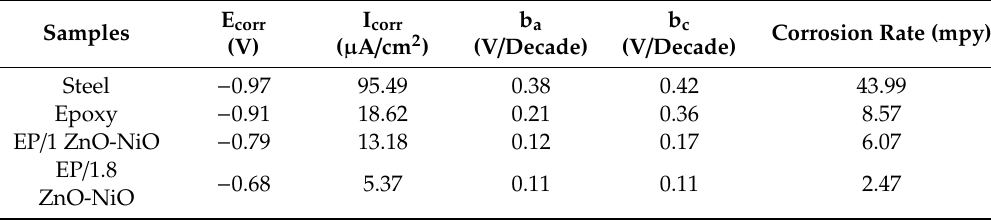
Figure 3. Potentiodynamic polarisation illustration for the steel, epoxy, epoxy/1.0 ZnO-NiO, and epoxy/1.8 ZnO-NiO nanocomposites. Table 2. Electrochemical data for different specimens from Tafel fitting.